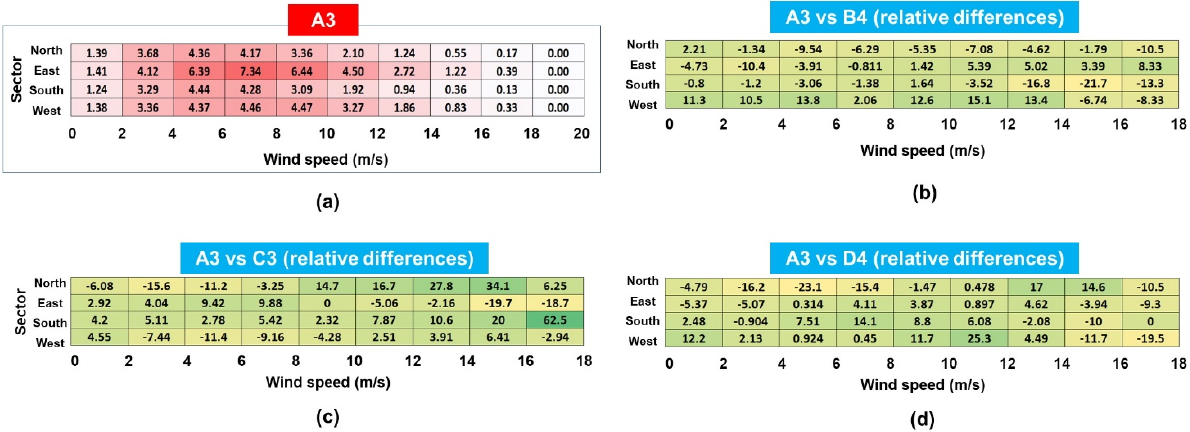
Figure 7. Distribution of the wind conditions ( U 100) by wind speed and directions, considering the 42-year time interval from January 1979 to December 2020. Results for: ( a ) A3-joint distribution; ( b – d ) differences (in %) reported between A3 and the sites B4, C3, and D4, respectively. A positive value indicates that, for A3, compared to the other sites, a higher share corresponds.